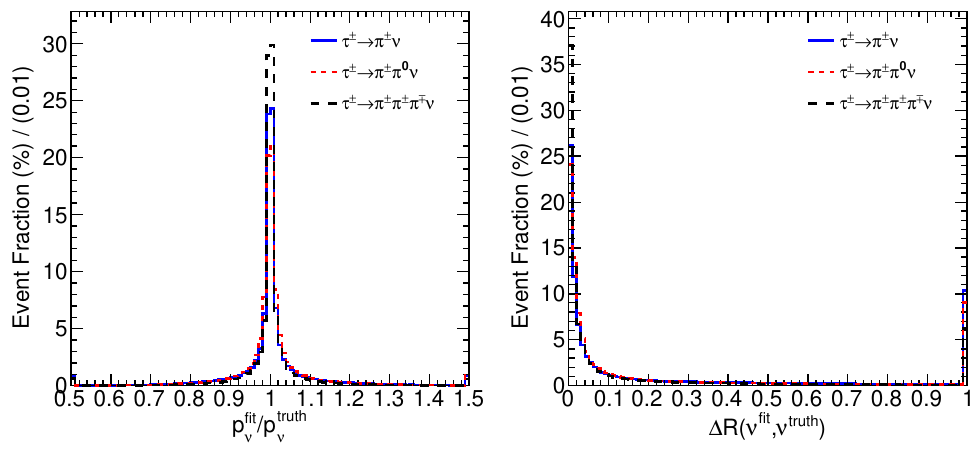
Figure 4 . The ratio of (cid:12)tted neutrino momentum to the true one (left), and the (cid:1) R distance between them (right). The left and/or right most bins contain the